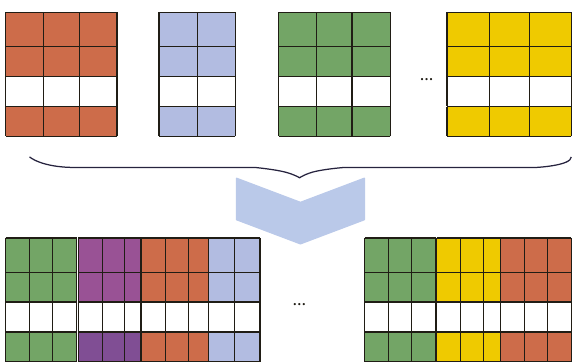
Figure 8: Schematic diagram of augmented matrix